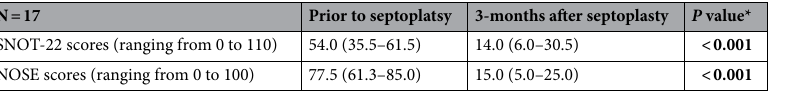
Table 1. Patient-related outcome measurements (PROM) following septoplasty. Significant values are in bold. All values are shown in median, (interquartile range). *P value calculated by using the Wilcoxon signed rank test between the pre-operative values and post-operative scores. NOSE Nasal obstruction symptom evaluation, SNOT Sino-nasal Outcome Test.